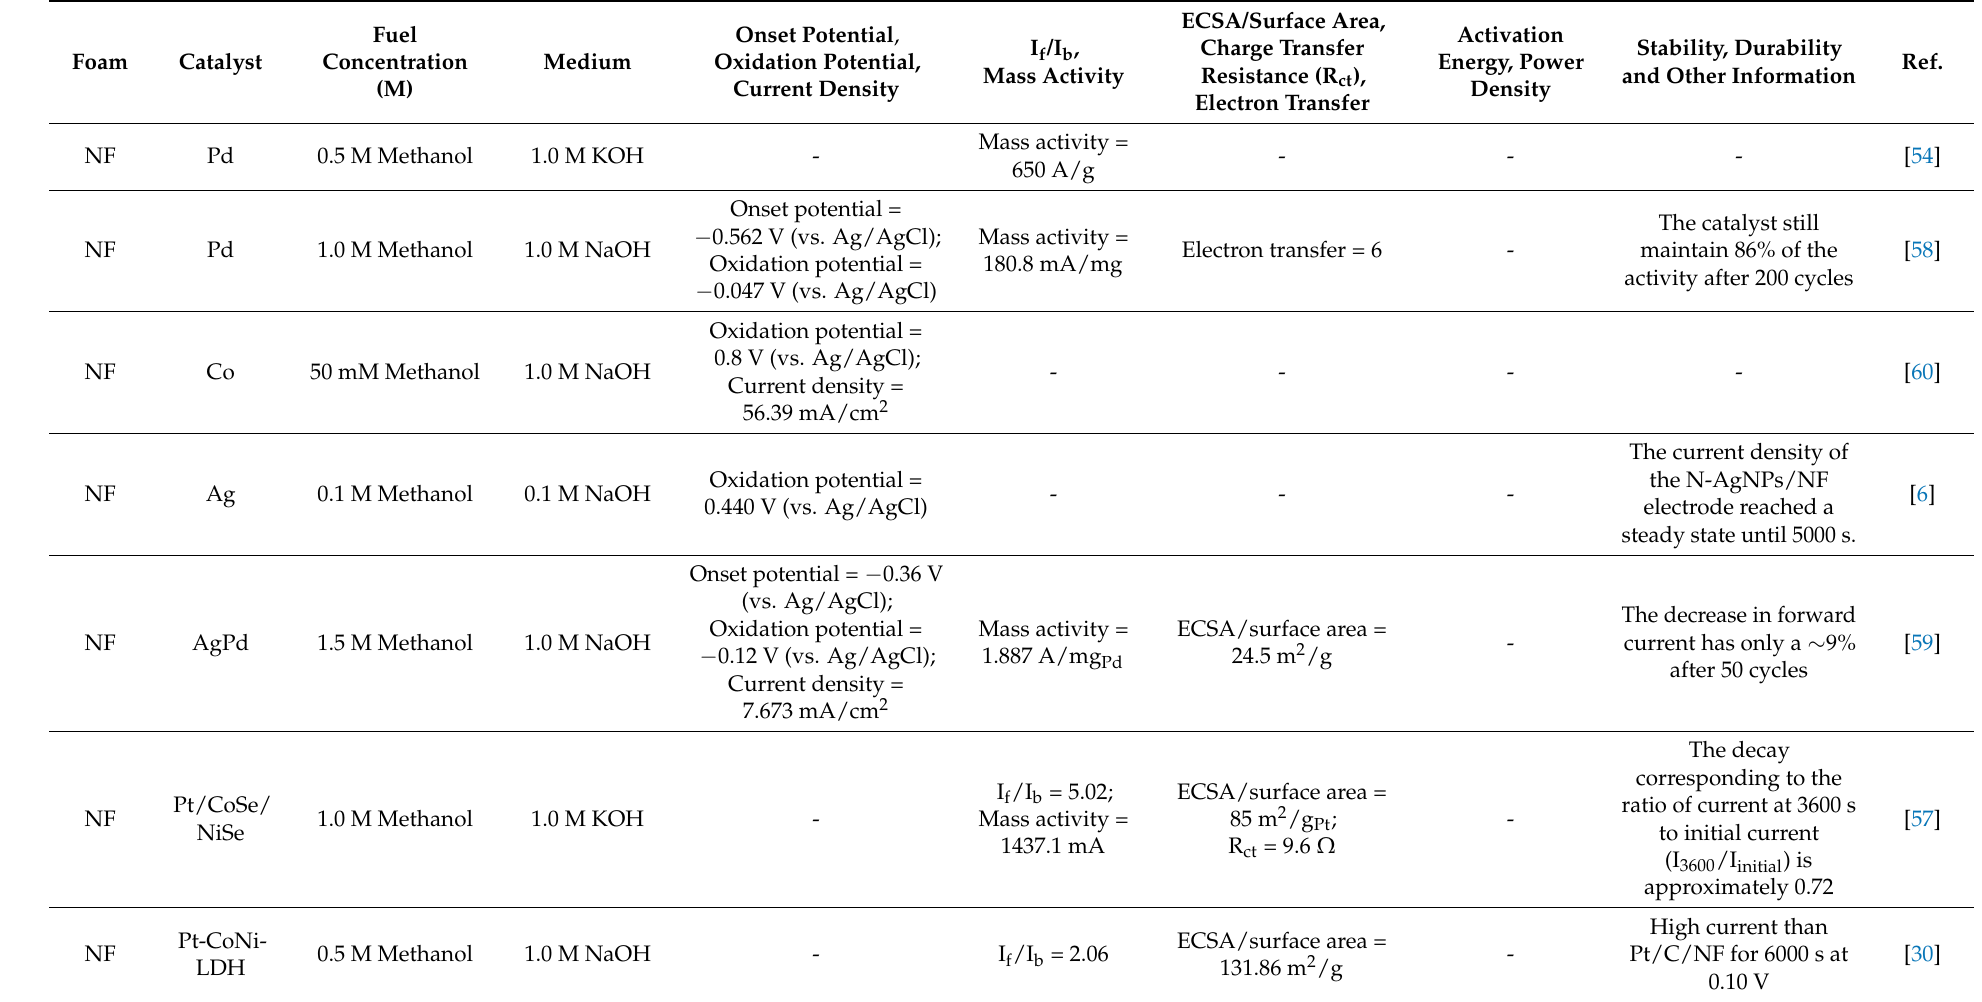
Table 1. The summarized application of NF and GF as catalyst supports and their performance in